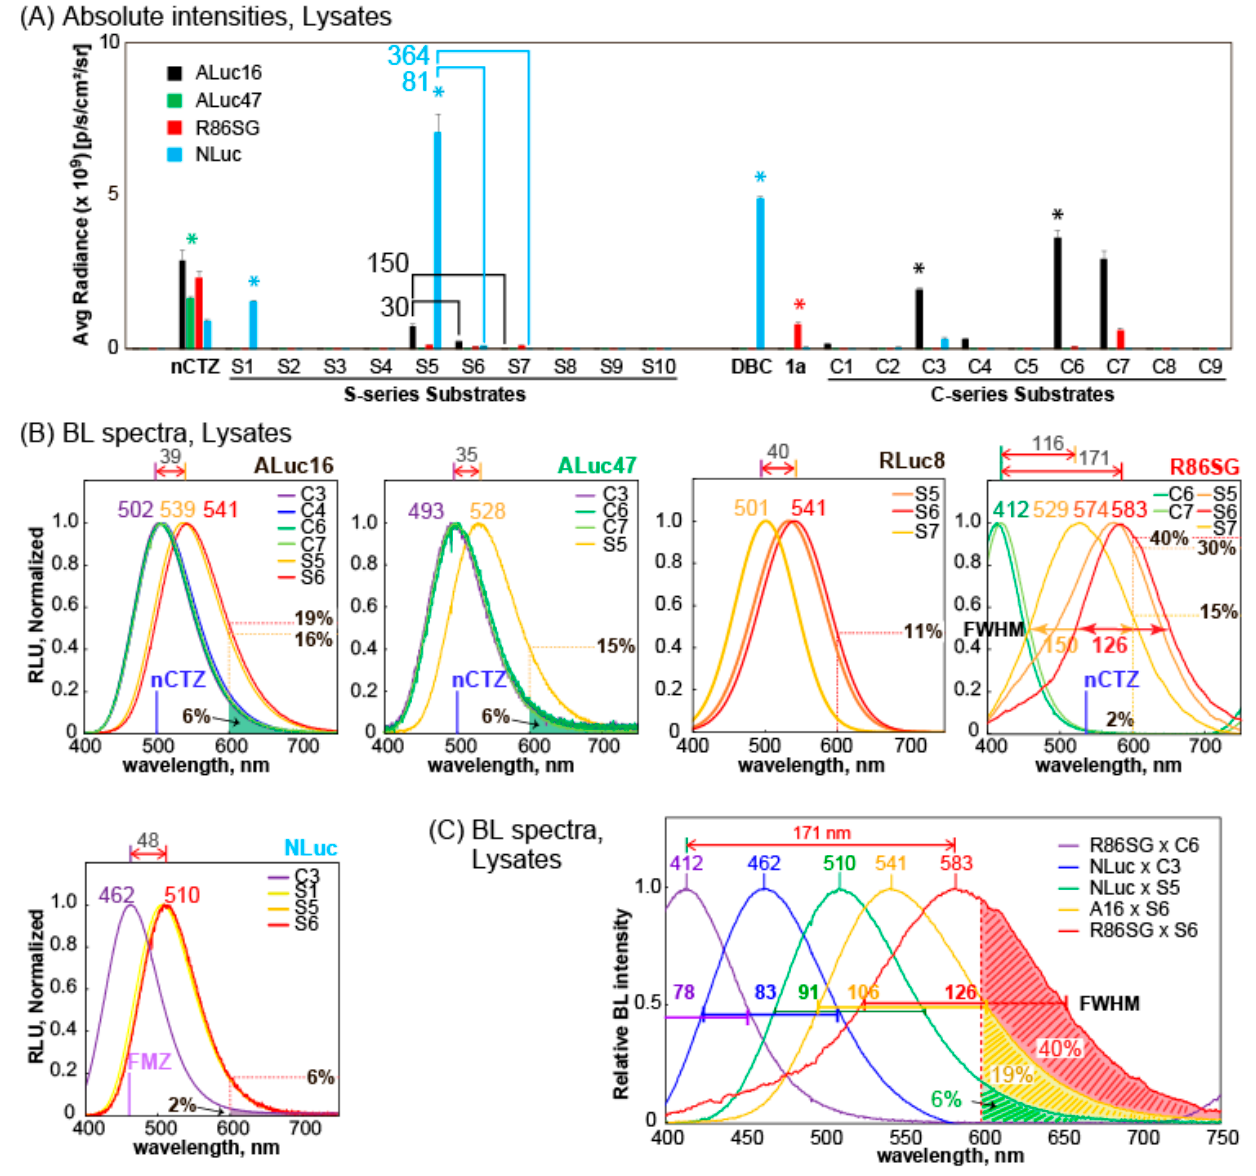
Figure 2. Characterization of S- and C-series CTZ analogues in the presence of marine luciferases. ( A) Comparison of absolute BL intensities of the S- and C-series CTZ analogues according to marine luciferases, ALuc16, ALuc47, R86SG, and NLuc. The asterisks denote characteristic BL signals. ( B ) The representative BL spectra of selected CTZ analogues in the presence of ALuc16, ALuc47, R86SG, and NLuc. ( C ) Normalized BL spectra of selected S- and C-series showing various colors covering all the visible regions. The numbers at the peaks denote the wavelengths at the maximal intensities ( λ max ). The full width at half maximum (FWHM) values were specified in the middle of the spectra.